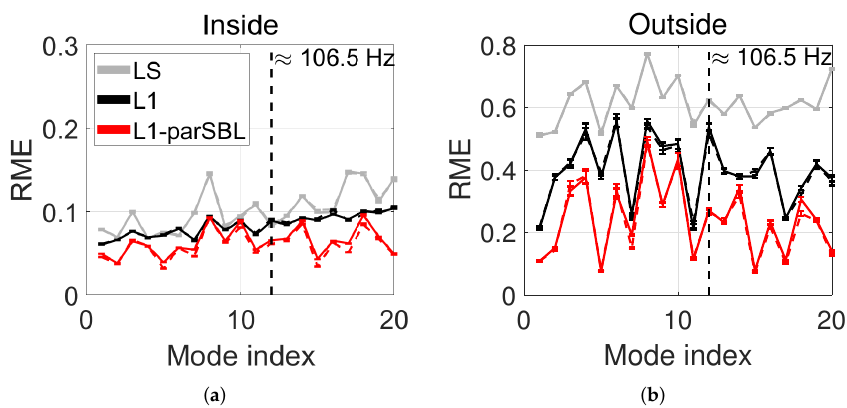
Figure 8. (Color online) RME of LS, L1, and L1-parSBL in different modes (—: R = 400; - -: R = 1000), ( a ) inside the virtual region and ( b ) outside the virtual region. Specifically, we considered the mode at approximately 106.5 Hz (closest to 107.5